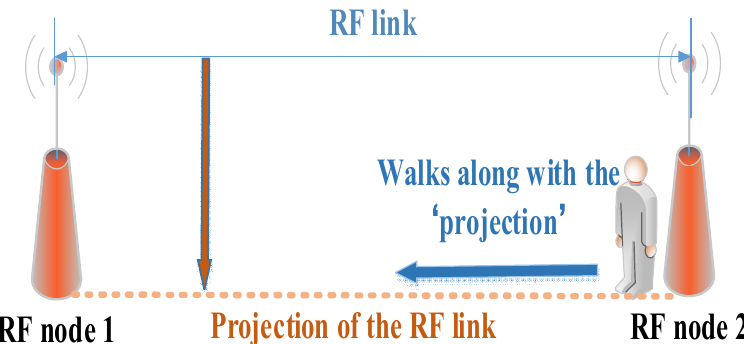
Figure 8. An illustration of the target moving. Figure 8 . An illustration of the target moving.